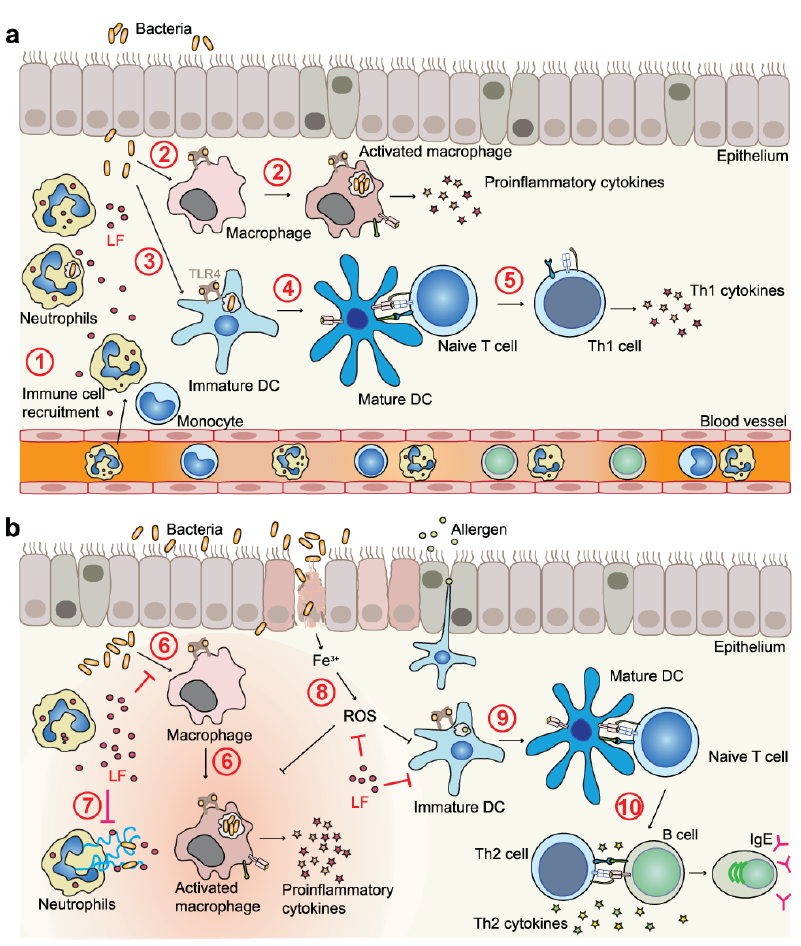
Figure 2. Modulation of cells of the innate and adaptive immune system by LF contributes to host defense. ( a ) In early phases of the immune response to invading pathogens, LF released from neutrophil granules has an immunostimulatory role because of its function as an alarmin to mediate immune cell recruitment from the bloodstream to the affected tissue (1) and by activation of myeloid cells—macrophages (2) and DCs (3) in particular. These LF actions might be in part related to its ability to serve as a PAMP carrier. Lastly, by promoting DC maturation (4), LF has a positive influence on functions of the adaptive immune system by activating, for instance, T cells (5). ( b ) In contrast, in chronic infection or inflammation (e.g., in allergic inflammation), LF exerts immunomodulatory functions and, therefore, protective effects via several mechanisms. LF efficiently counteracts the excessive proinflammatory responses of macrophages triggered by PAMPs (6) and shrinks neutrophil extracellular traps (7). LF also efficiently scavenges free ferric iron, thereby blocking deleterious ROS production (8). In allergy, LF is known to modulate DC functions (9), thereby skewing the immune response from the harmful Th2 to the protective Th1 type (10) that is accompanied by reduced production of allergen-specific IgE antibodies by B cells.